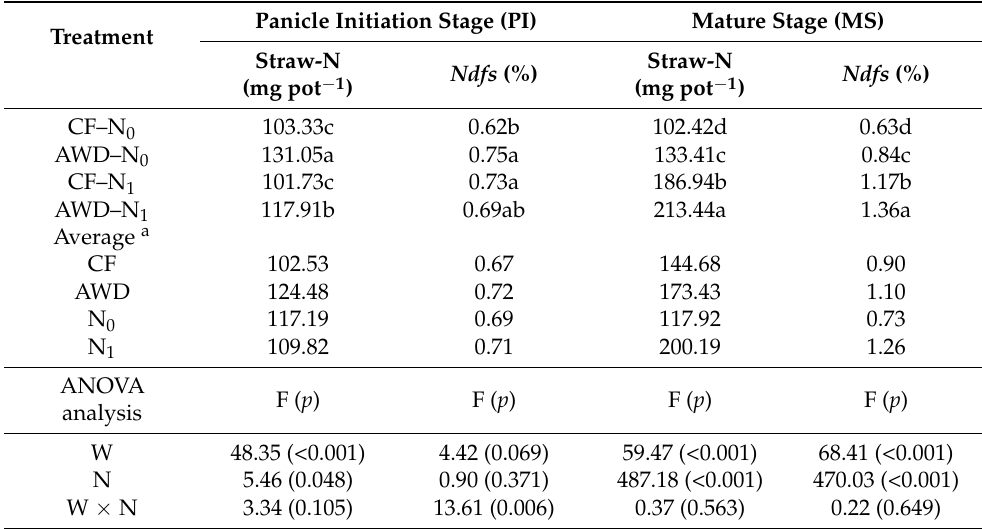
Table 4. Amount of straw-N in soil and its contribution to the soil N pool under different